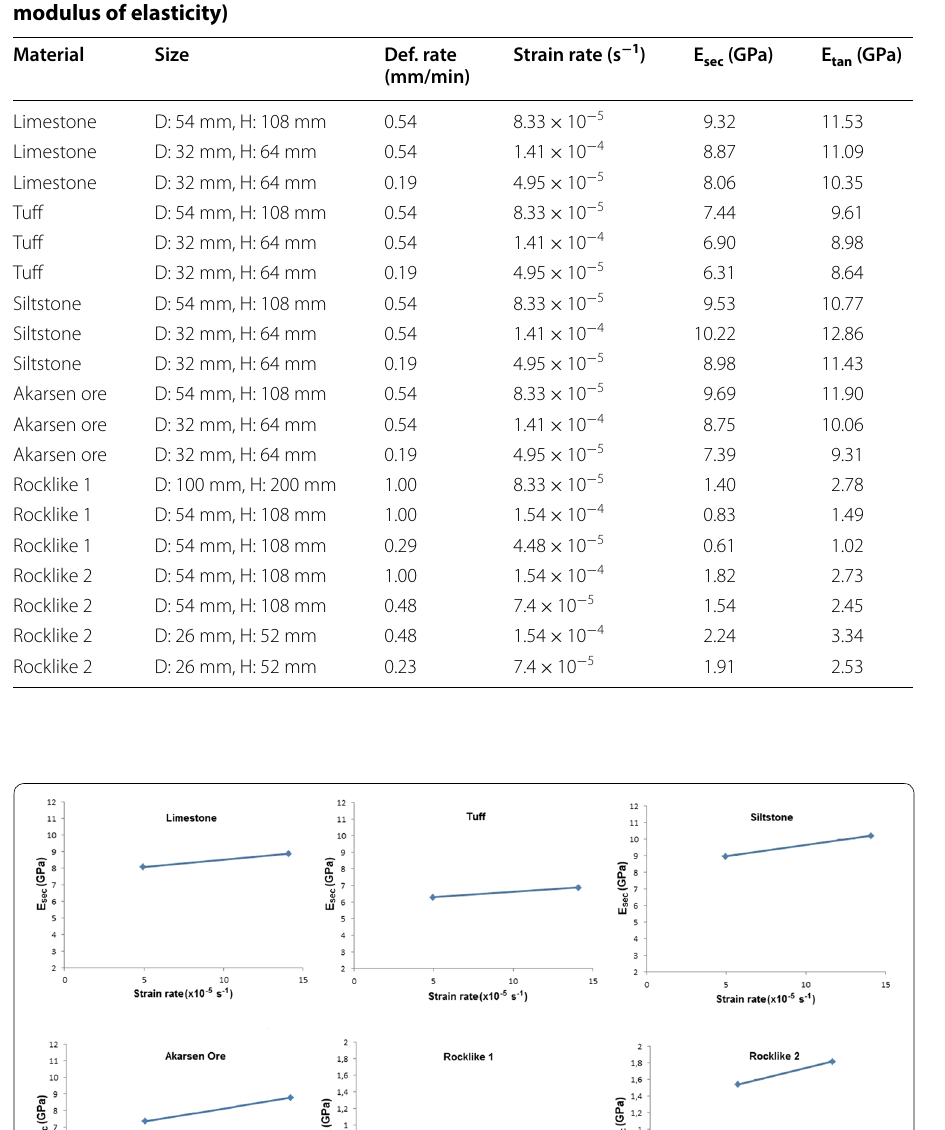
: secant modulus of elasticity, E sec